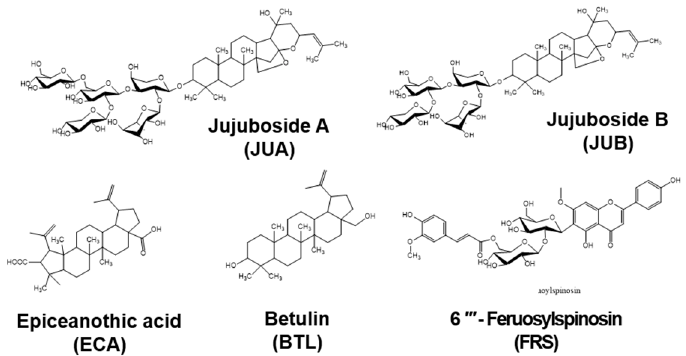
Figure 1. Chemical structure of flavonoid glycosides isolated from Z. jujuba var. inermis (Bunge) Rehder seeds.